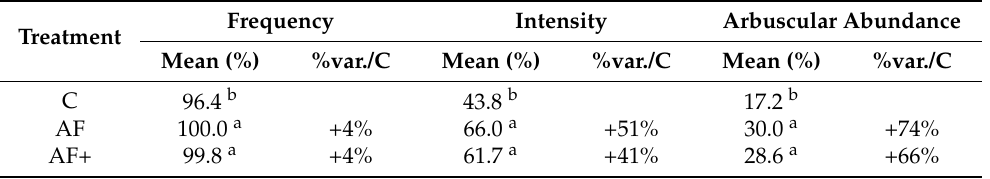
Table 2. Mycorrhizal colonization of roots (0–30 cm of depth) of durum wheat growing in the three treatments (C, AF and AF+) collected at heading stage in 2017, expressed as: frequency of mycorrhiza in the root system (% of colonized fragments), intensity of mycorrhizal colonization (% of fragment length colonized) and arbuscular abundance (% of fragment length with arbuscular presence) (n = 18). Average results in AF and AF+ treatments are expressed also in percentage variation as compared to the C treatment. Within a column, means with different letters are significantly different according to Tukey’s HSD test ( p ≤ 0.05). Frequency Intensity Arbuscular Abundance Treatment Mean (%) %var./C Mean